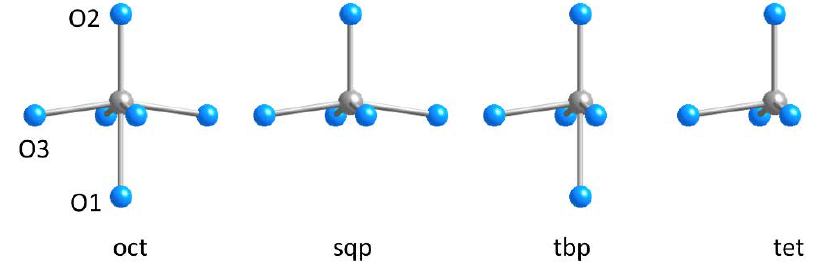
Figure 3. Possible coordination environments for the B-cations (gray) in the perovskite block of N 2 - annealed (oxygen deficient) n = 2 RP phases: oct = octahedron, sqp = square pyramid (O1 vacancy), tbp = trigonal bipyramid (1 O3 vacancy), and t = tetrahedron (1 O1 and 1 O3 vacancy). Table 2. Selected interatomic distances (Å) and angles ( ◦ ) for as-prepared in N 2 and air-annealed x = 0.0